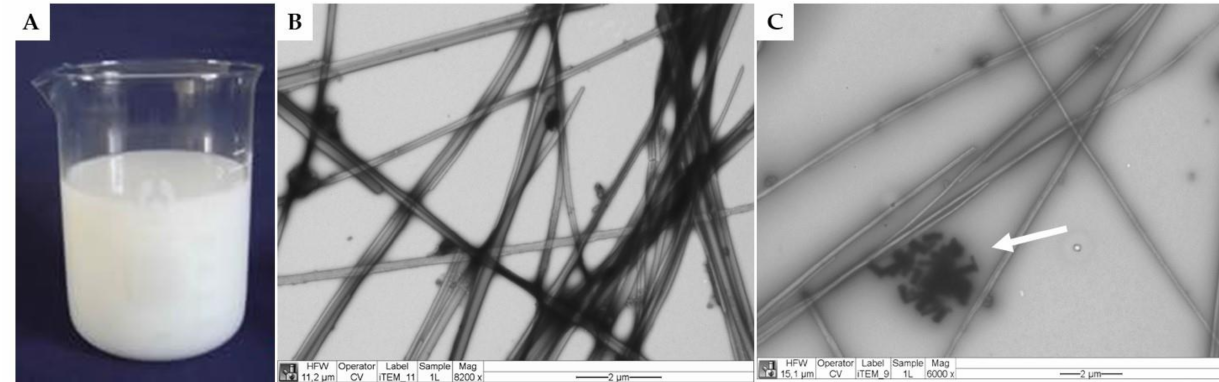
Figure 2. Macroscopic ( A ) and microscopic aspect by transmission electron microscopy of cochleates derived from S . Infantis ( B and C ). The white arrow indicates crystals from the calcium solution added to the formulations for cochleate formation ( C